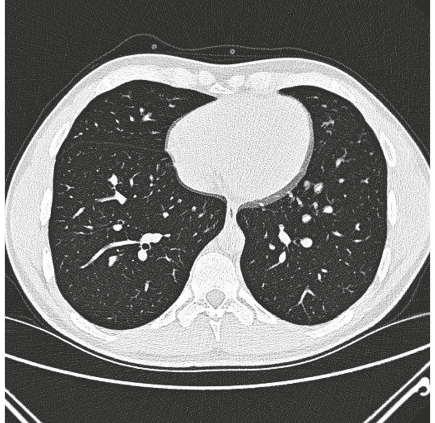
Figure4:AnormalchestCTscanofthepatientobtainedthreeyears after the